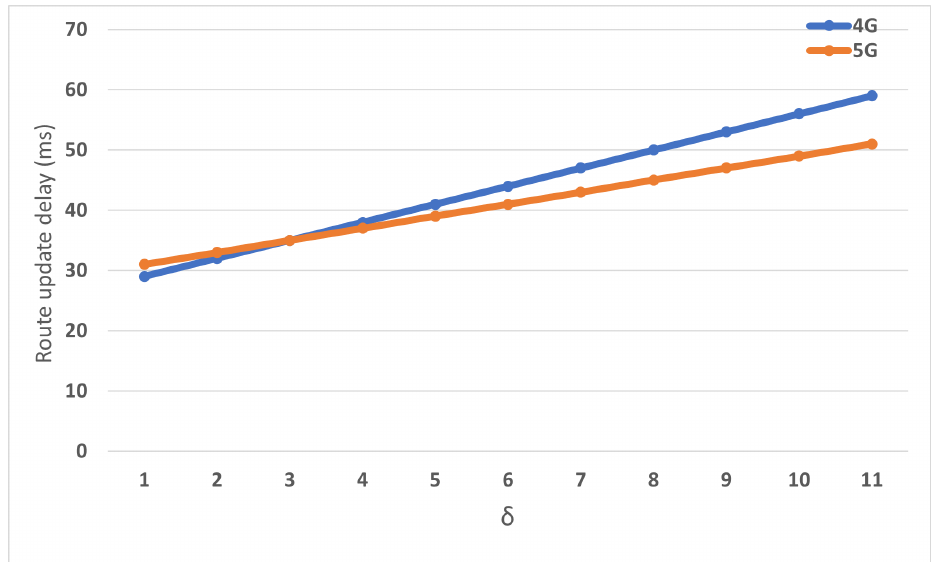
Figure 12. The impact of δ on the handover delay.